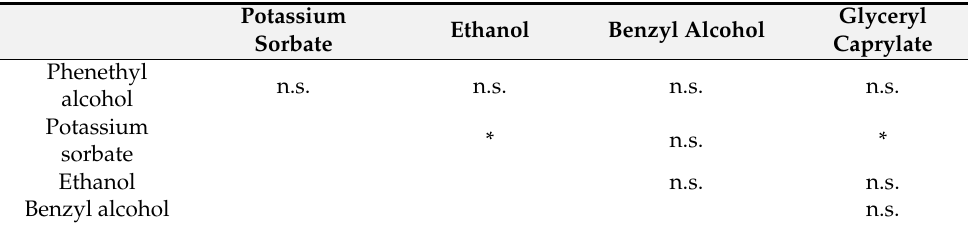
Table 4. Significance of daily oxygen consumption rate (mg O 2 /100 g/d) depending on used preservative after 96 days at 30 ◦ C under light exposure between two samples using one-tailed two-sample t -test for different variances ( α < 0.05 = *, not significant = n.s.). Potassium Glyceryl Ethanol Benzyl Alcohol Sorbate Caprylate Phenethyl n.s. n.s. n.s. n.s. alcohol Potassium * n.s. * sorbate Ethanol n.s. Benzyl